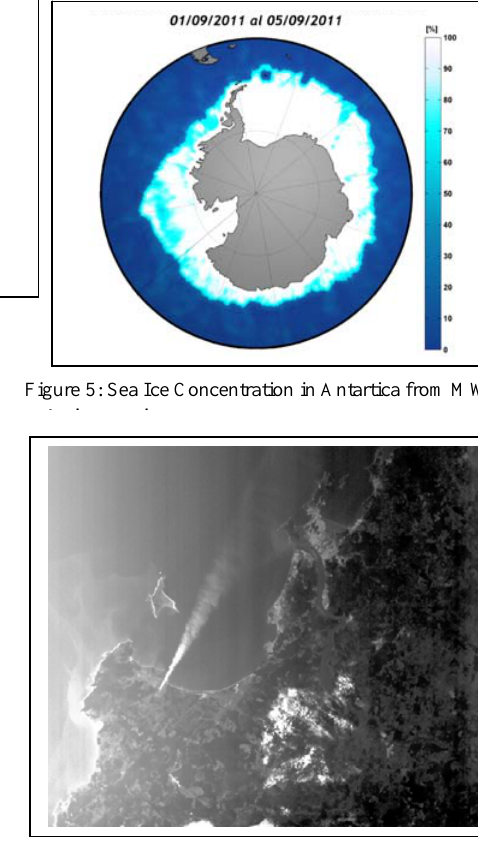
Figure 7: Fire detected by HSC in Arauco Gulf